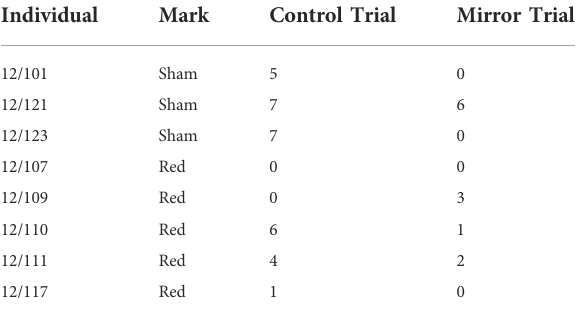
TABLE 2 Frequency of touches to marks observed in the test. Individual Mirror